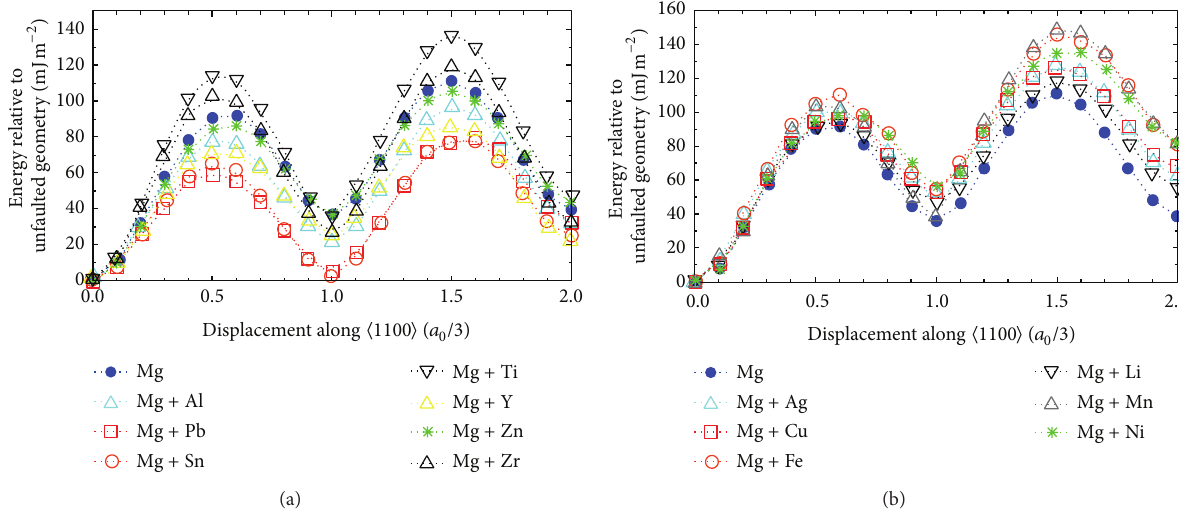
Figure 2: GSF energy curve of Mg and Mg alloys in the (0001)[1100] slip system. The figure is adapted from